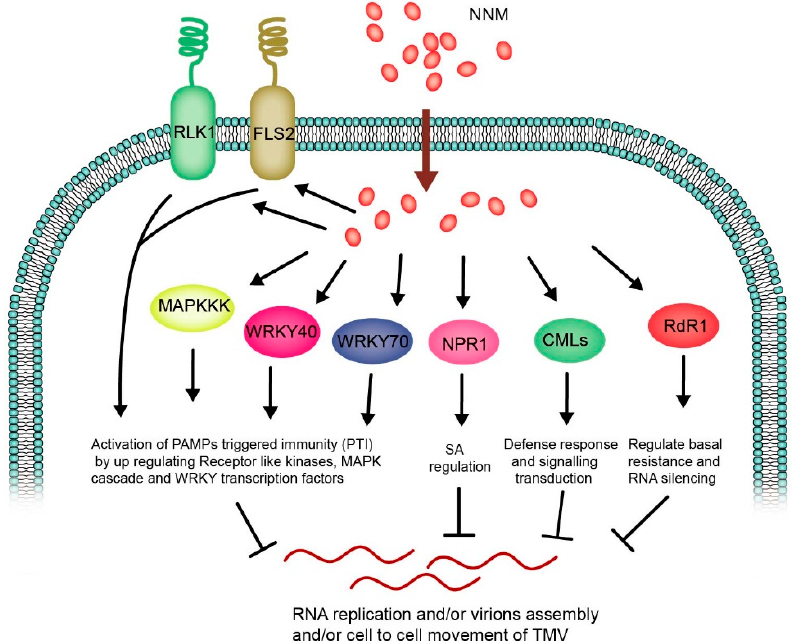
Figure 4. A model for crucial genes regulation involved in anti-TMV mechanisms by treatment of